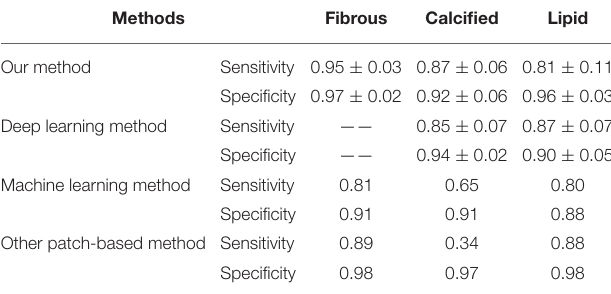
TABLE 3 | Comparison of our method with other state-of-the-art segmentation methods published previously in terms of sensitivity and specificity (—— means the author did not segment the corresponding